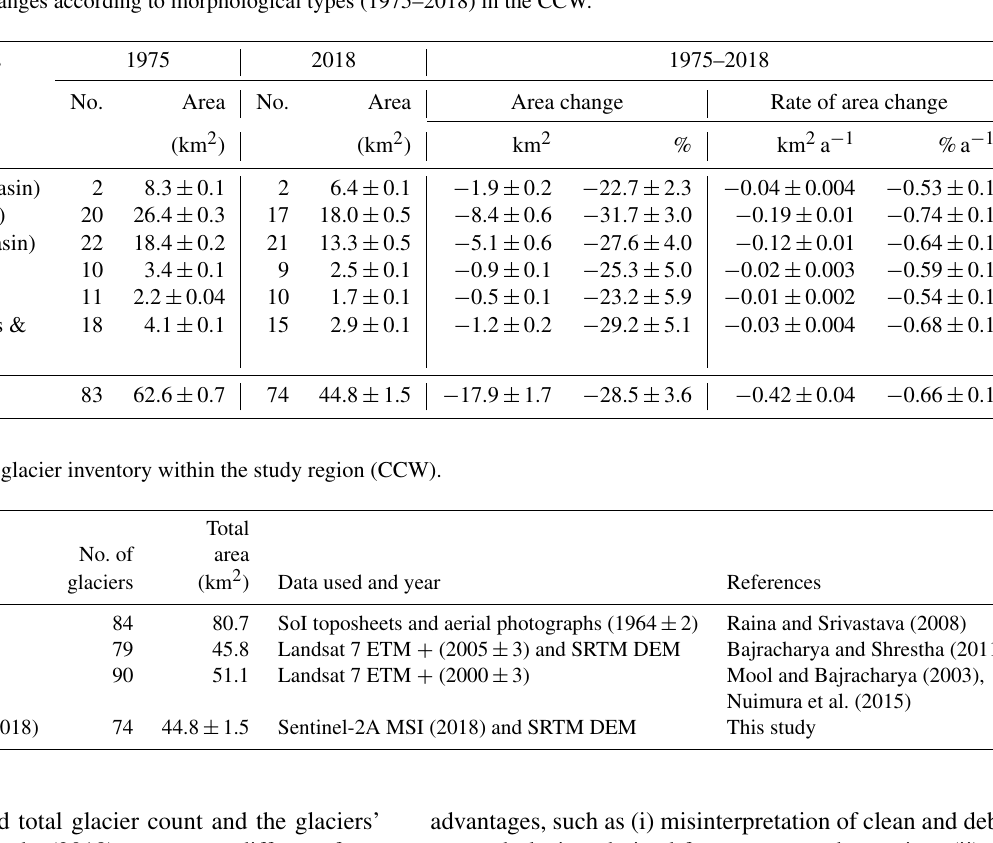
Table 6. Glacier area changes according to morphological types (1975–2018) in the CCW. Morphological types